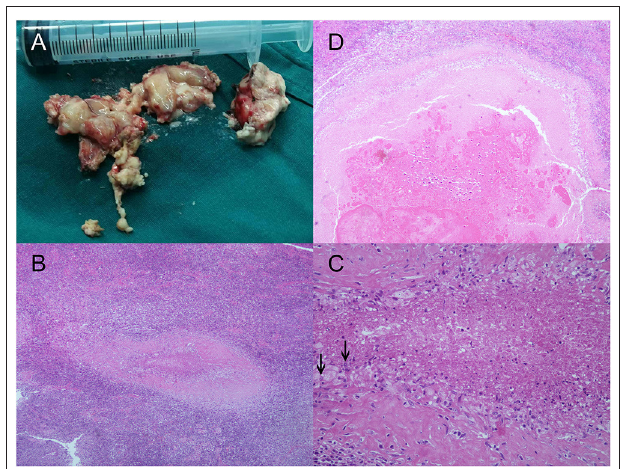
FIGURE 2 | Larval samples and the pathologic results of cerebral sparganosis in the case. (A) Larva samples acquired during the operation in our hospital. Necrotic objects split into band shaped sections from the larva were wrapped in surrounding brain tissue. The larva adhered to the surrounding brain tissue because of severe inflammatory reactions and therefore was not fully presented. (B,C) Images of microscopy inspection of the sample under low power (HE, × 100) and high power (HE, × 400) are also presented, which are characterized by irregular striped necrotic objects with inflammatory infiltration of multinucleated giant cells and the formation of foreign body granulomas. Calcareous corpuscles, which were characterized by basophilic vacuolated structures in the larva body, were indicated with black arrows. (D) Coronal section of the necrotic object (HE, ×